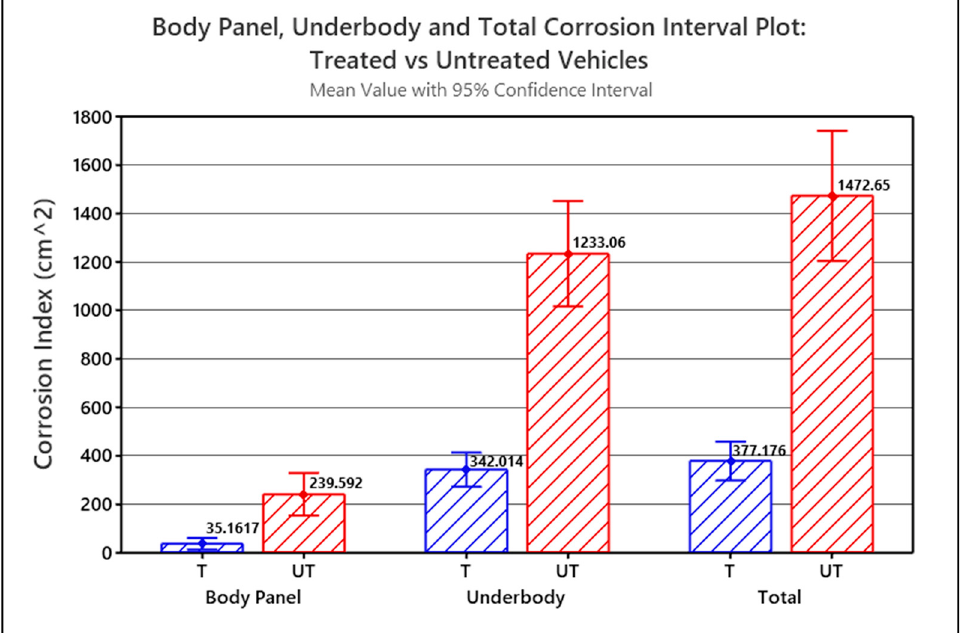
Figure 6. Interval plot for Body Panel corrosion, Underbody corrosion and Total Corrosion (i.e., Underbody + Body Panels) comparing treated (T) versus untreated (UT) vehicles ( p < Table 2. Summary of statistics for single-factor ANOVA analysis of corrosion index versus treat- ment for treated and untreated vehicles.